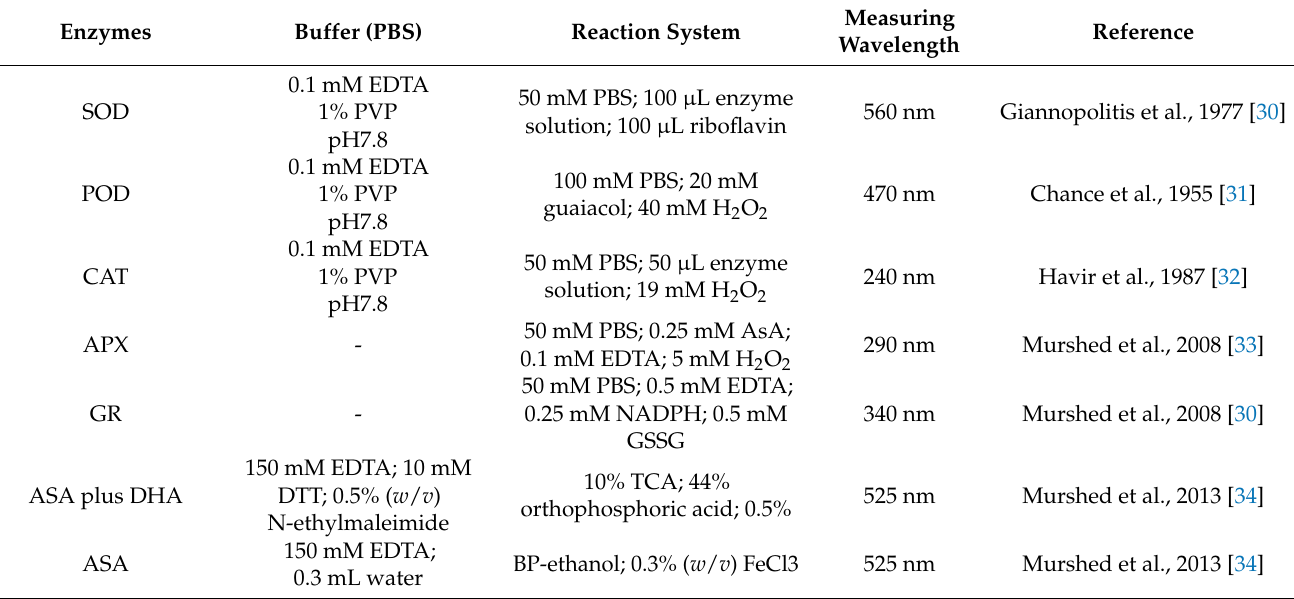
Table 2. Methods used for determining enzyme activities and antioxidant